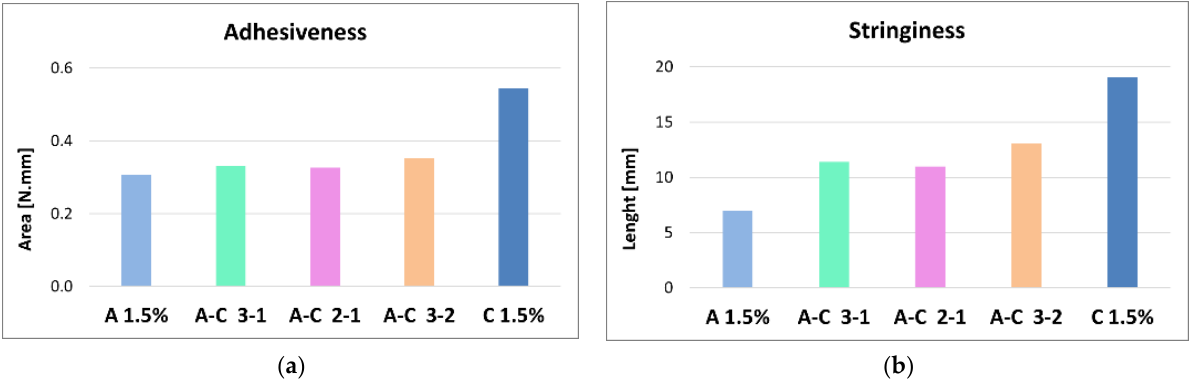
Figure 16. Textural parameters of adhesiveness ( a ) and stringiness ( b ) measured by an immersion/de-immersion test for the samples prepared with A–C associations at different ratios (1:0, 3:1, 2:1, 3:2, 0:1) at 1.5% w/w of the total polymer amount.